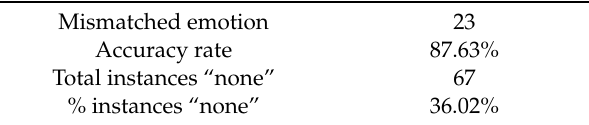
Table 3. Accuracy results for emotion recognition, and instances and percentage for no recognized emotion